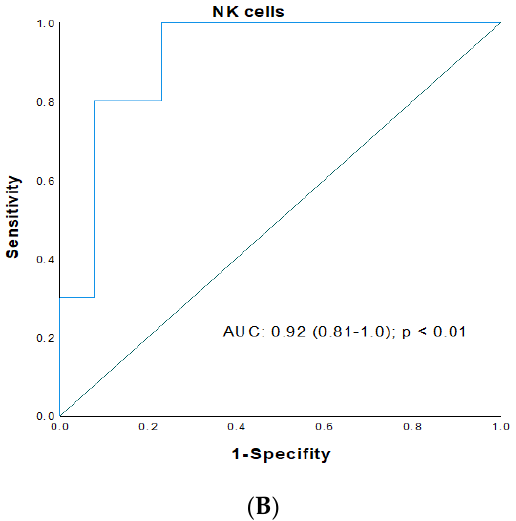
Figure 3. Receiver operating characteristic curve for ( A ) monocyte values on POD 7 and ( B ) NK cell value on POD 7 as predictors for early renal graft injury (eRGI) following renal transplantation.